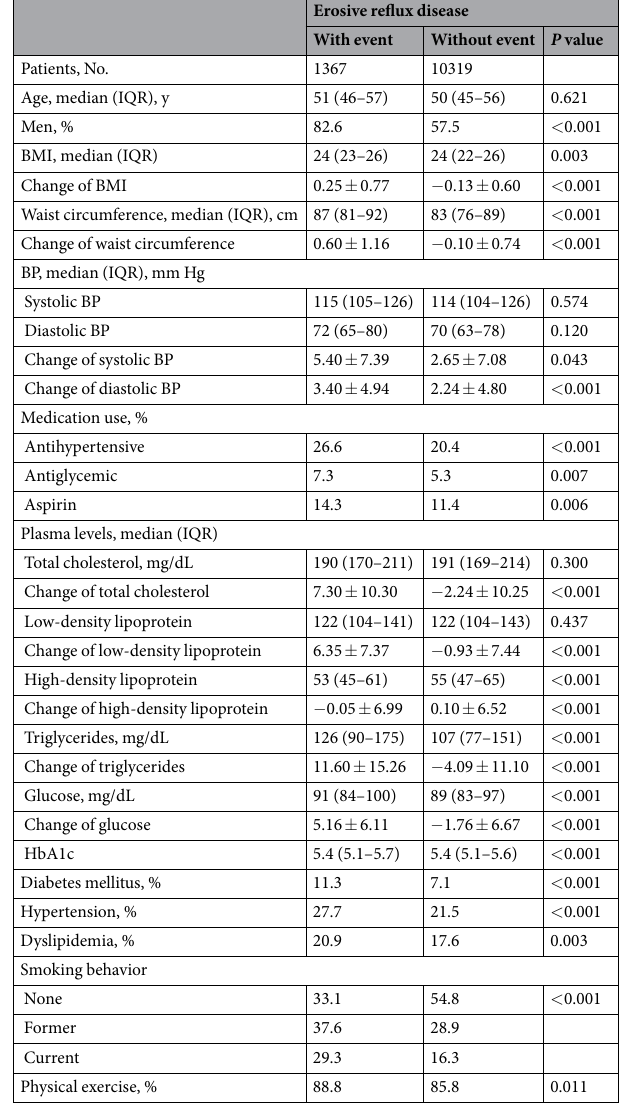
Table 2. Baseline characteristics of participants by incident erosive reflux